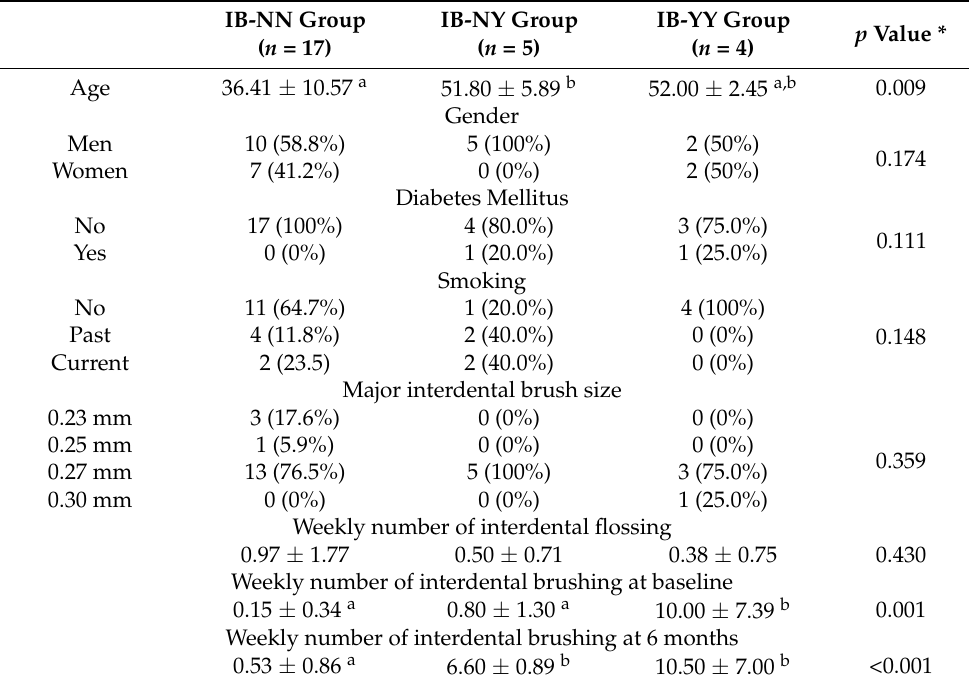
Table 3. Characteristics of the study population according to interdental brushing compliance ( N = 26).